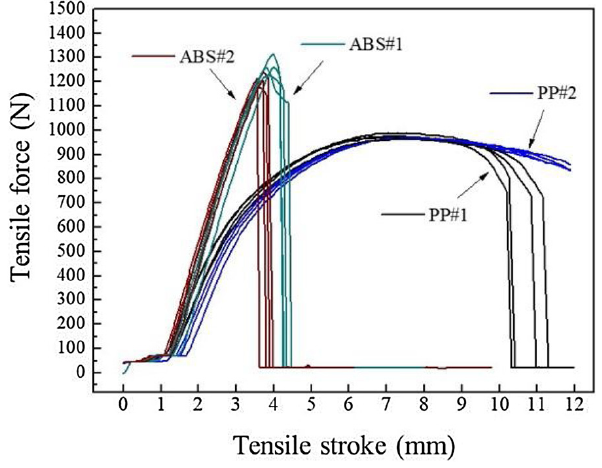
Figure 11. Tensile test for PP and ABS moulded parts with different injection speed [52]. Table 2 summarises the process and material parameters which can be deduced by both conventional and sol-gel fabricated UTs. Table 2. Process and product information extracted from different types of ultrasonic probes in different locations of the Injection